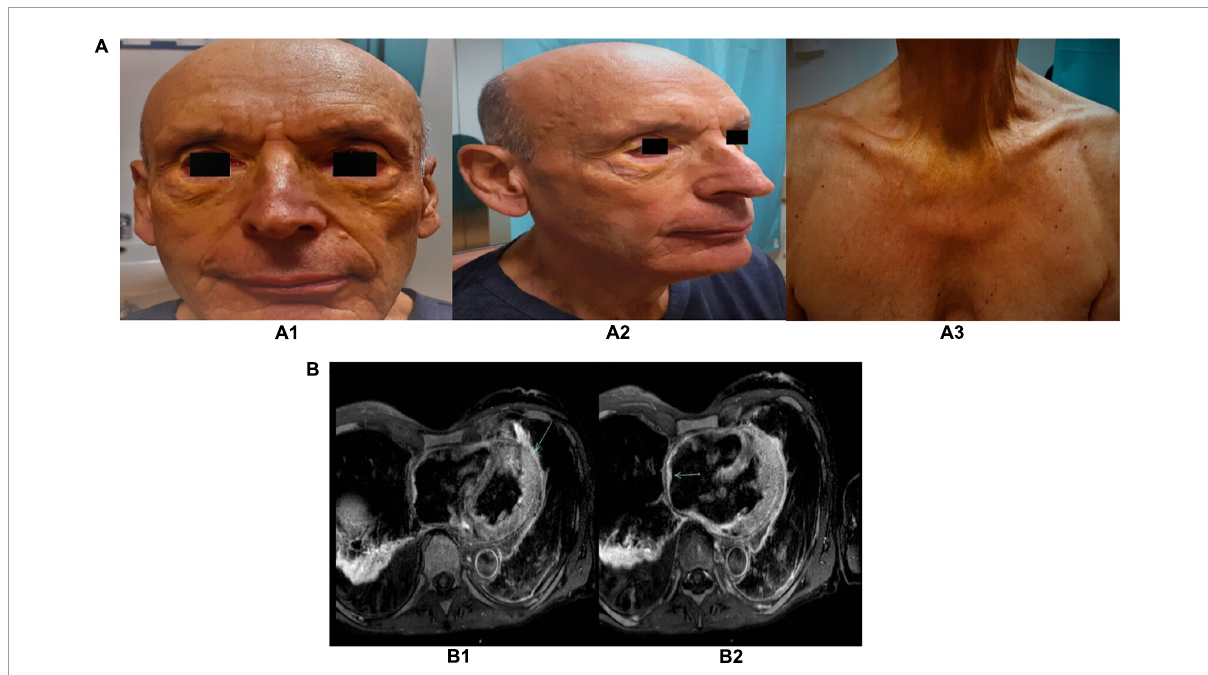
FIGURE1 (A) Pictures of the xanthelasmas of the eyelid and thorax. Several yellowish plaque/papules on both upper and lower eyelids, cheeks (A1,A2) , and anterior region of the thorax (A3) . (B) Cardiac magnetic resonance images. Post-gadolinium T2-weighted sequences, showing a gadolinium-enhanced pericardial nodule (B1) and the pseudotumor of the right atrial roof (B2)